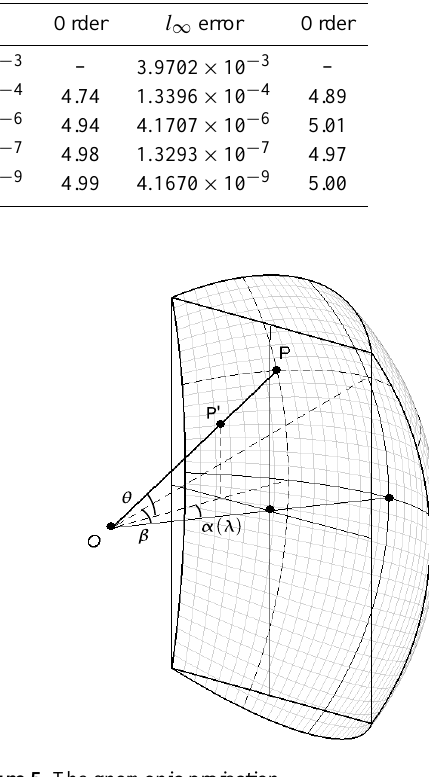
Figure 5. The gnomonic